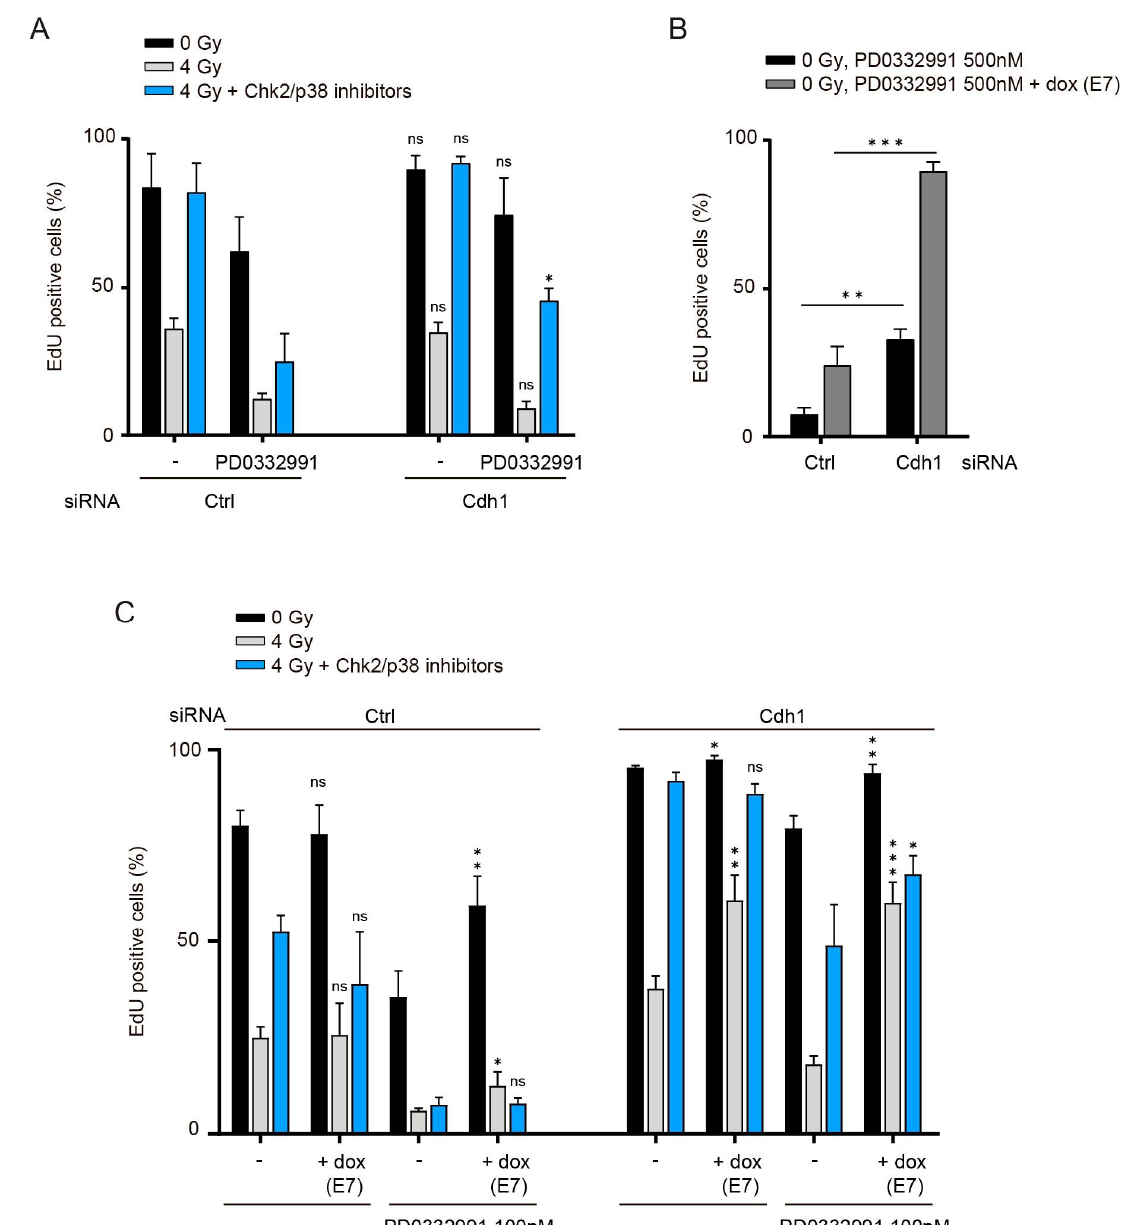
Figure 5. Cdh1 depletion and pocket proteins inactivation restore G1 recovery in the absence of Cdk4/6 activity: ( A ) RPE-1 cells were transfected with the indicated siRNA during serum starvation and G1 recovery was assessed as in 1A. PD0332991 100 nM was added 16 h after irradiation when indicated. Depicted are the means and SD from three independent experiments. Significance was calculated by comparing control or Cdh1-depleted cells that where otherwise treated similarly (e.g., Cdh1-depleted 4 Gy irradiated cells that were treated with PD0332991 were compared to control-depleted 4 Gy irradiated cells that were treated with PD0332991). ( B ) RPE-E7 cells were transfected with the indicated siRNA during serum starvation. PD0332991 500 nM was added in G1 for 40 h, together with doxycycline, when indicated. Depicted are the means and SD of two independent experiments. ( C ) RPE-E7 cells were transfected with the indicated siRNA during serum starvation and G1 recovery was assessed as in 1A. PD0332991 and doxycycline were added 16 h after irradiation where indicated. Depicted are the means and SD of three independent experiments. Significance was calculated by comparing cells treated or not with doxycycline, that were otherwise treated similarly (e.g., Cdh1-depleted cells that were 4 Gy irradiated and subsequently treated with Chk2/p38 inhibitors, PD0332991 and doxycycline were compared to the same cells without doxycycline). For all panels, significance was calculated using a one-sided unpaired t -test. * p < 0.05, ** p < 0.01, *** p < 0.005, ns = not